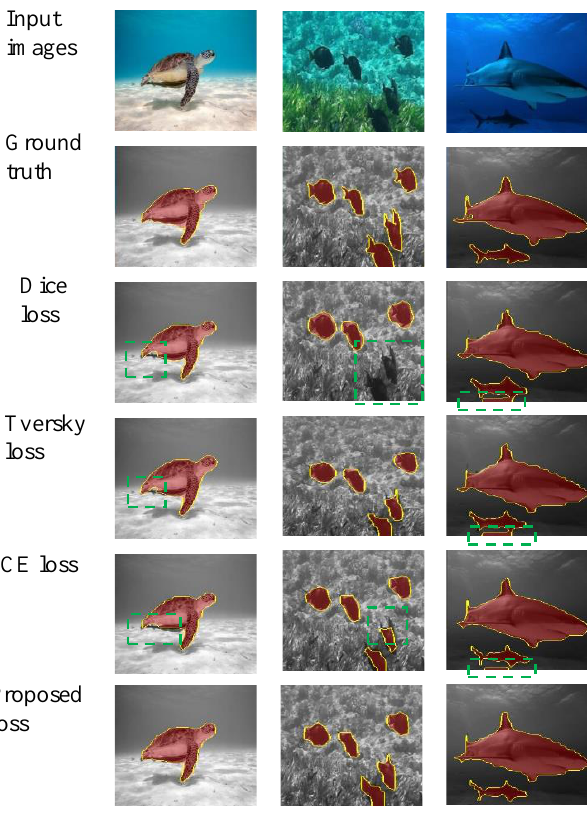
Figure 7. Representative fish segmentation results by the proposed model when trained with different losses on the SIUM fish data. The Ground truths and Predictions are overlaid on the gray scale image for better visualization. The green dot rectangulars denote the undersegmented regions Table 4. Comparison between the fish segmentation performance when using the proposed loss and comparative